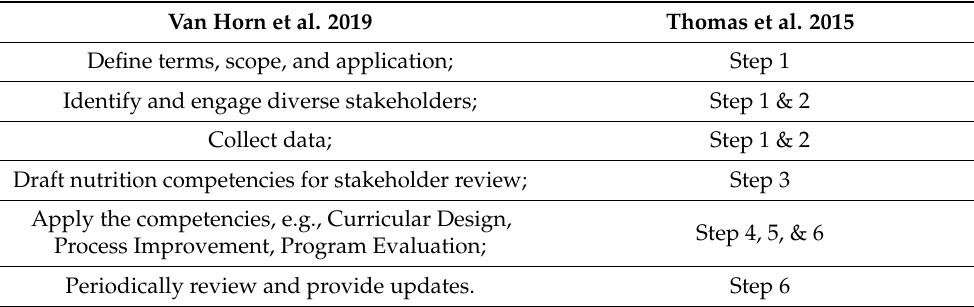
Table 1. Comparison of the Approaches of Van Horn et al. and Thomas et al. Van Horn et al.